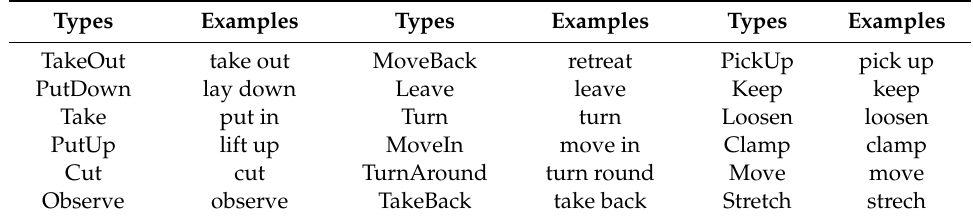
Table 8. Categories of v1 (verbs that should be executed in order).